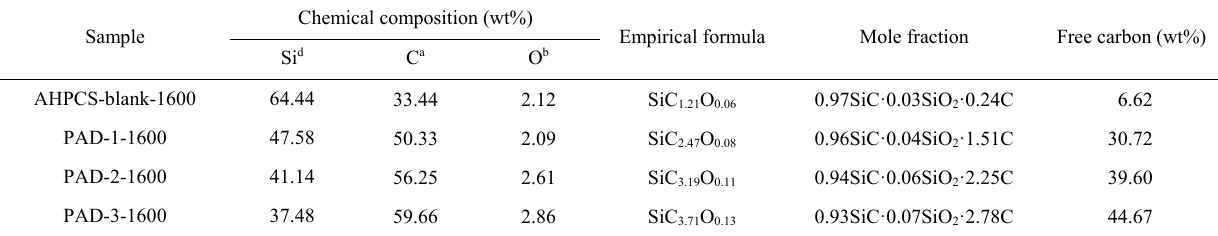
Table 2 Chemical composition of 1600 ℃ ceramics derived from different precursors